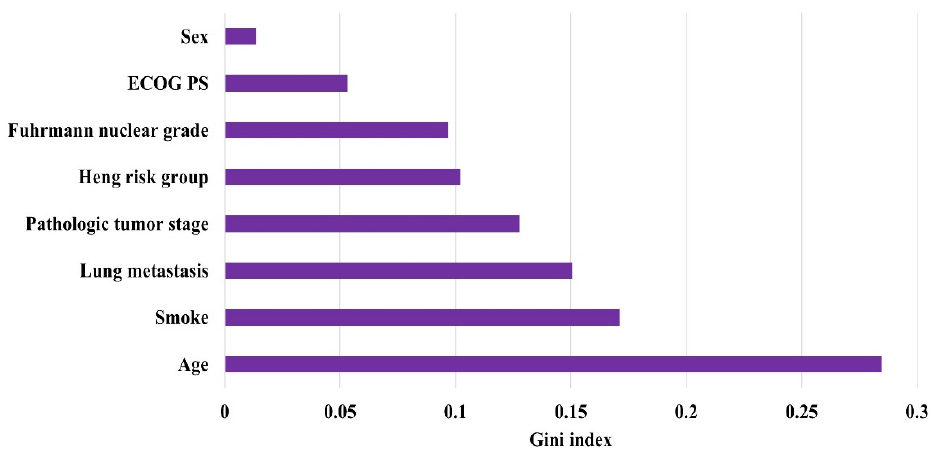
Figure 4. Variable importance in the AdaBoost model.